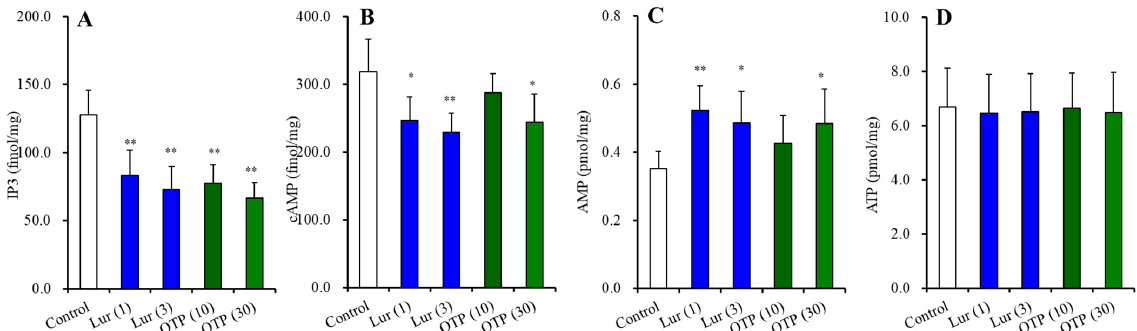
Figure 4. Effects of chronic administration of lurasidone (Lur: 1 and 3 mg/kg/day for 14 d), quetiapine (QTP: 10 and 30 mg/kg/day for 14 d) on intracellular levels of IP3 ( A ), cAMP ( B ), AMP ( C ), and ATP ( D ) in the hypothalamus. Ordinates indicate mean ± SD ( n = 6) of levels of IP3, cAMP (fmol/mg) and AMP, ATP (pmol/mg) in the rat hypothalamus. *: p < 0.05, **: p < 0.01: relative to control by ANOVA with Tukey’s post hoc